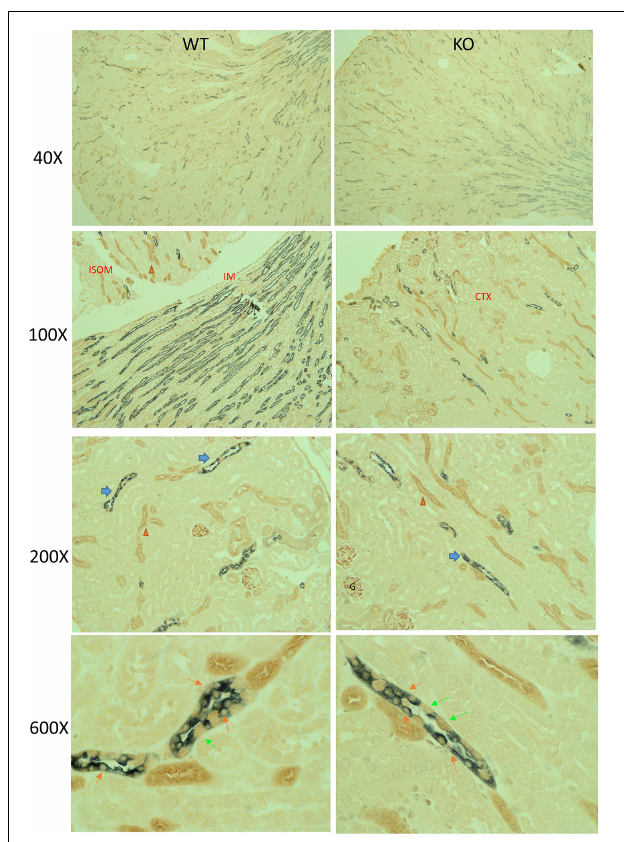
FIGURE 2 | Mechanistic Target of Rapamycin (mTOR) immunohistochemistry (IHC) in mouse kidney. Paraffin-embed kidney coronal sections were prepared for double-labeling IHC by standard chromogenic approaches; mTOR (brown) and AQP2 (gray) in male KO and WT mouse kidneys under control dietary conditions. Sections were imaged at 40 × , 100 × , 200 × , and 600 × total magnification, as indicated. At 200 × , blue and orange arrows point to collecting duct and thick ascending limbs, respectively, which displayed relatively stronger mTOR labeling than other cells of the kidney (including proximal tubule). Glomerular (G) also displayed strong mTOR labeling. Under 600 × , orange and lime-green arrows indicate principal and intercalated cells, respectively. Principal cells were identified by dual gray and brown label. KO mice had reduced brown labeling in cells co-staining with gray.